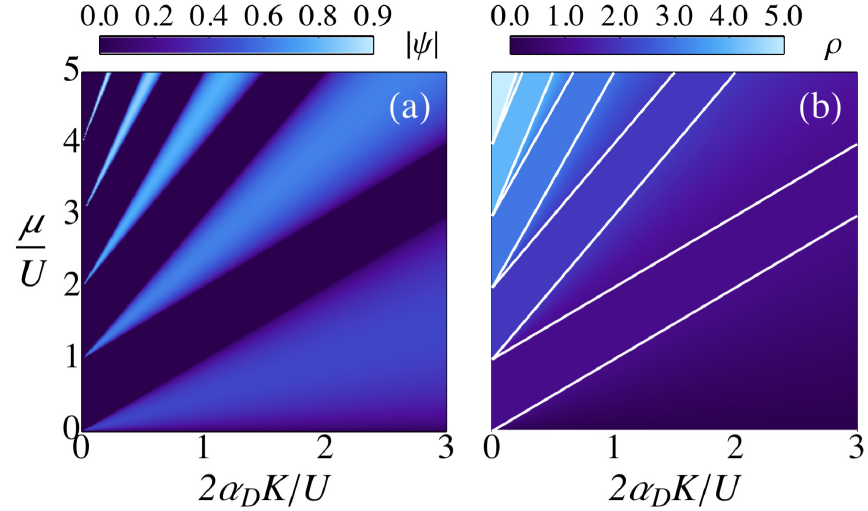
Figure 5. Phase diagram of the bosonic system with quantum optical lattice for /U = 0 . ( a ) Superfluid order homogeneous scattering from the atoms in the limit t 0 parameter: bright areas correspond to the superfluid state with minimal atomic fluctuations and dark areas to Mott-insulator regions. ( b ) Local density: Mott insulator plateaus surround minimal uncertainty superfluid states with consecutive Fock-state fillings, and white lines denote phase